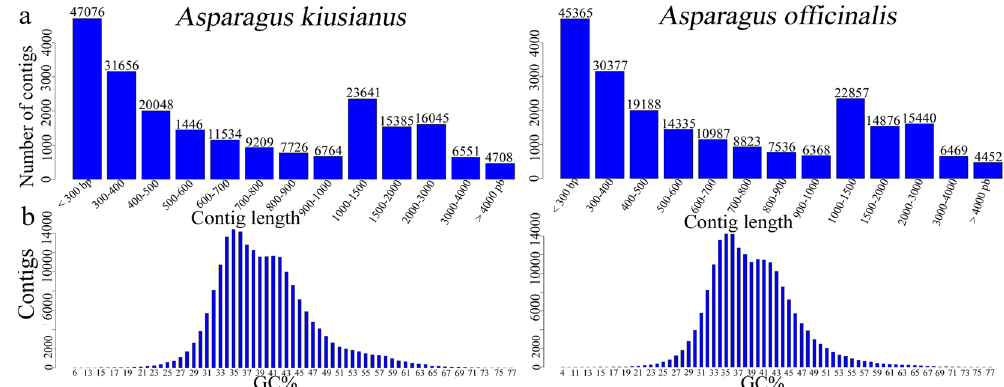
Figure 2. Transcript length and GC-content distribution graph in Asparagus officinalis and A . kiusianus . ( a ) Length distribution of assembled transcriptome fragments in A . officinalis and A . kiusianus . ( b ) GC-content percentage distribution in unique transcripts of A . officinalis and A . kiusianus